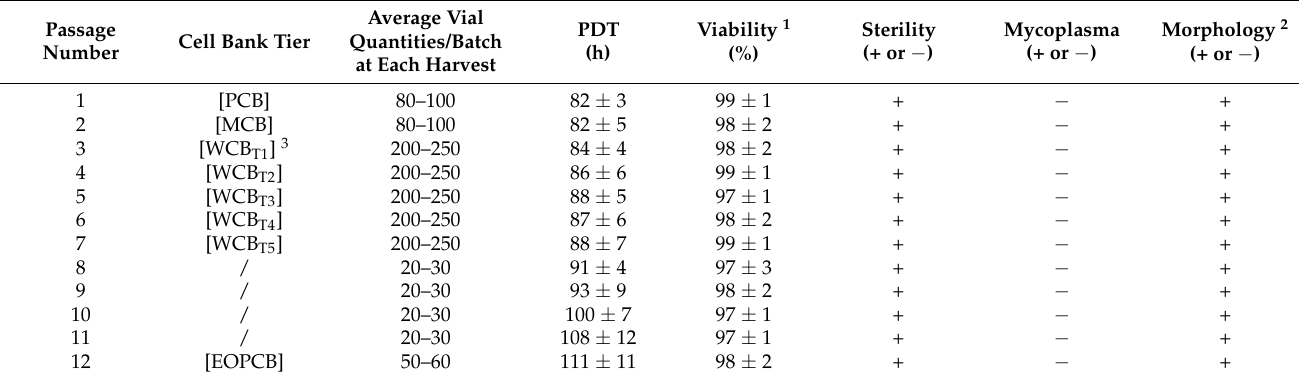
Table 2. Results of large-scale banking campaigns carried out for the FE002-Ten cell type following specifically optimized technical specifications and using optimized culture conditions. EOPCB, end of production cell bank; MCB, master cell bank; PCB, parental cell bank; PDT, population doubling time; WCB, working cell